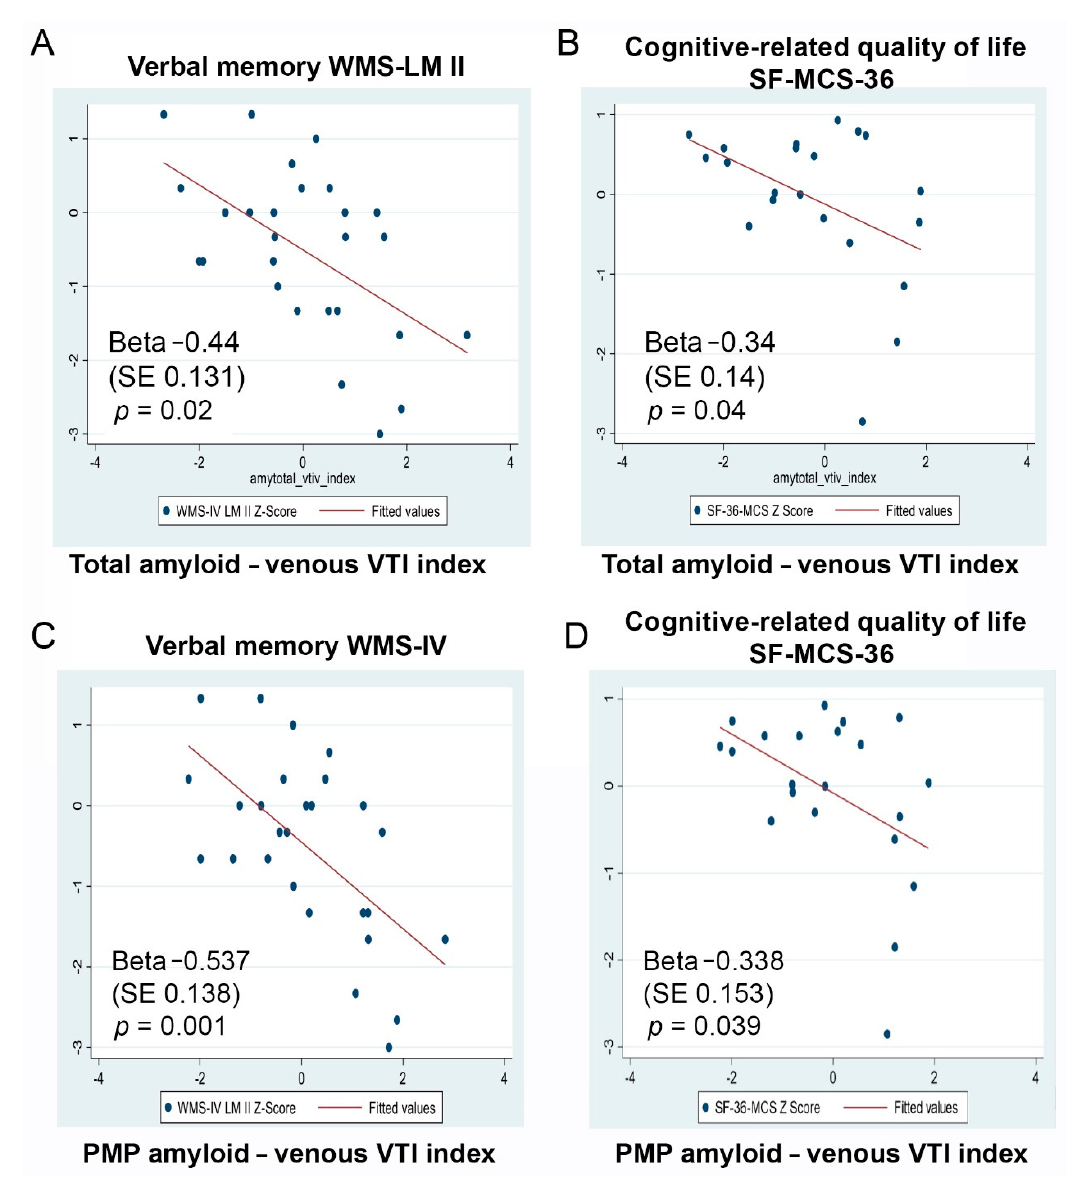
Figure 3. Retinal amyloid count combined with retinal venous VTI correlated with verbal memory and cognitive-related quality-of-life measures. Graphs illustrating the correlations between the combined total amyloid-venous tortuosity index and verbal memory ( A ) and cognitive-related quality-of-life Z-scores ( B ), and the correlations between the combined proximal mid-periphery amyloid-venous tortuosity index and verbal memory ( C ) and cognitive-related quality-of-life Z-scores ( D ). Abbreviations: WMS-IV LM II, Wechsler Memory Scale IV Logical Memory II; WMS-IV, Wechsler Memory Scale IV; SF-36 MCS, SF-36 Mental Component Score; PMP, proximal mid-periphery; and VTI, vessel tortuosity index.